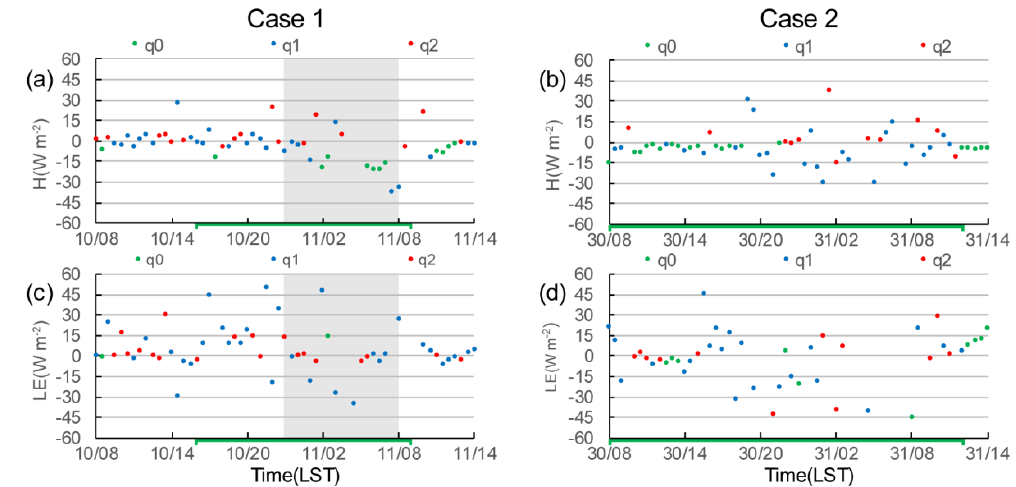
Figure 12. Sensible- and latent-heat fluxes over sea (23.4 m MSL). ( a ) Case 1, sensible. ( b ) Case 2, sensible. ( c ) Case 1, latent. ( d ) Case 2, latent. Dots are the flux values, averaged over 30 min. Missing data are either out of range or doubtful. Colors mark the quality flags of the fluxes, with q0 = green (see labels at top) the highest quality, q2 = red the lowest (see Table 2 for details). The green line indicates the sea-fog period, the grey shading indicates the inland-fog period.